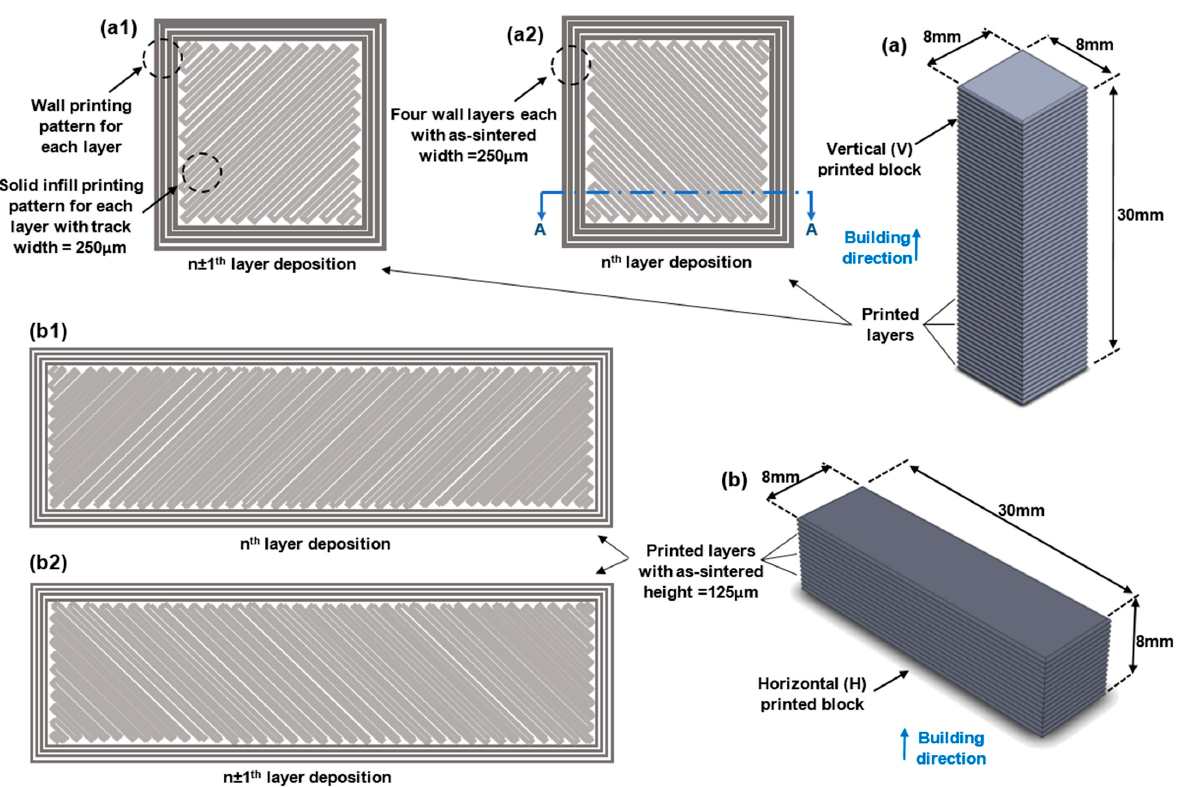
Figure 3. As-sintered 17-4 PH stainless steel ( a ) vertical (V) and ( b ) horizontal (H) blocks using the BPE Markforged Metal X system. ( a1 , a2 , b1 , b2 ) Schematic solid infill and wall printing pattern of n th and ( n ± 1 ) th layers for V and H blocks.